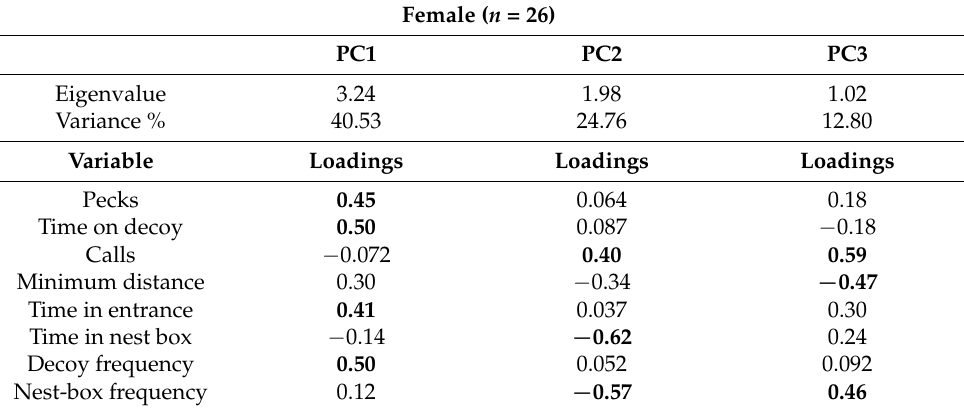
Table 1. Results from the principal component analysis for females, including eigenvalues, percentage of variance explained and factor loadings. Data include responses on both male ( n = 26) and female ( n = 26) decoys. The minimum distance is reversed (multiplied by − 1), so larger values indicate more confrontational aggression. The factor loadings for PC1 are reversed (multiplied by − 1) for the same reason. Variables with loadings greater than 0.40, deemed important for the construction of the components, are highlighted in bold.